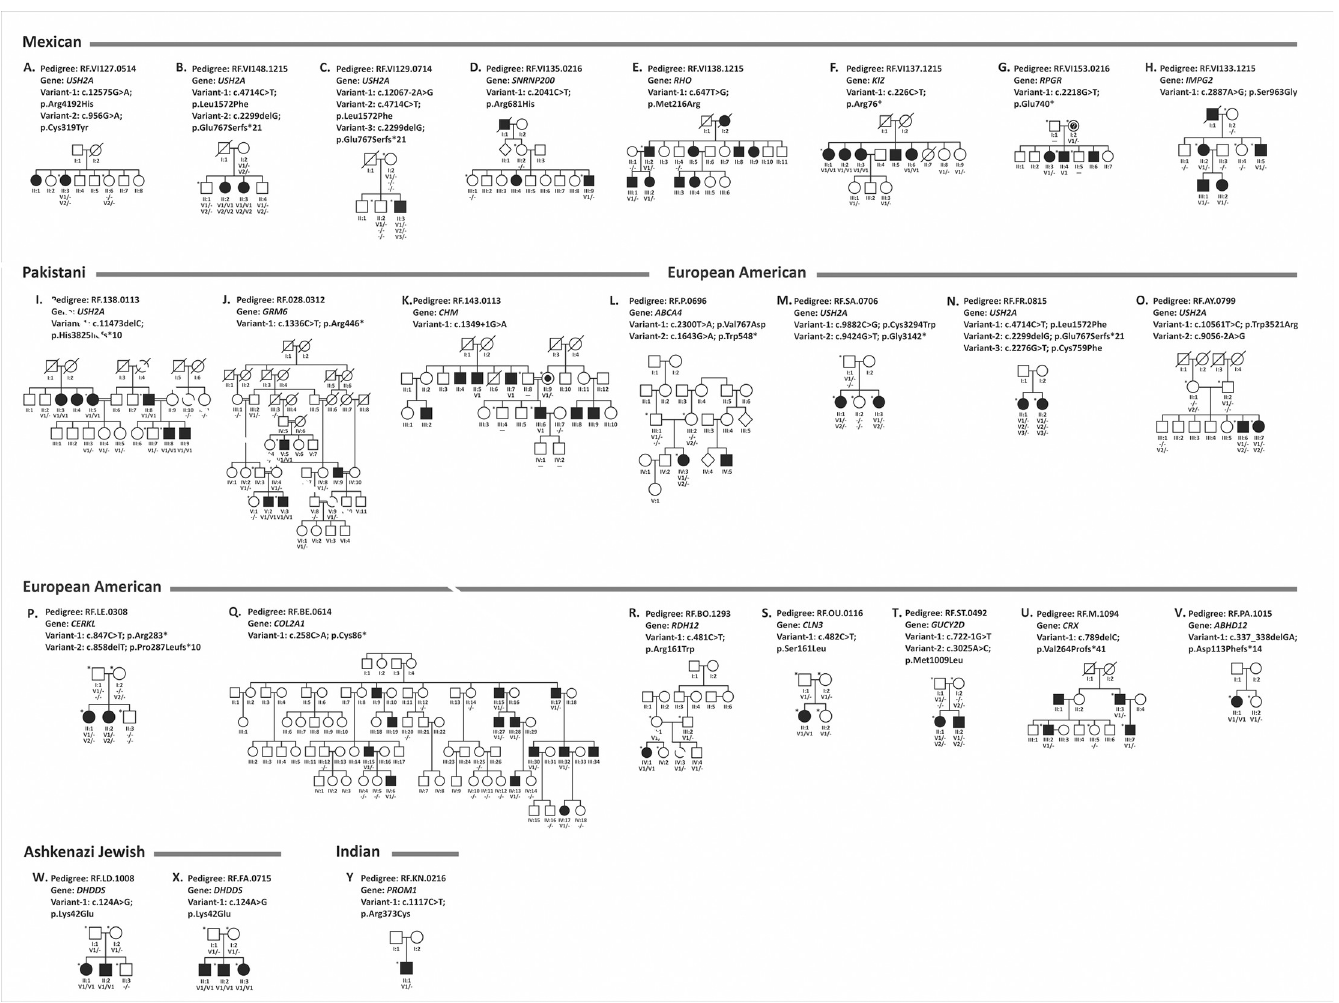
Fig 2. Pedigrees with previously reported mutations. The segregation analysis revealed 35 previously reported mutations that were identified in 25 pedigrees. There were seven frameshift, 17 missense, seven premature stop codon mutations, and four splice site altering changes. Of these ten are homozygous, six